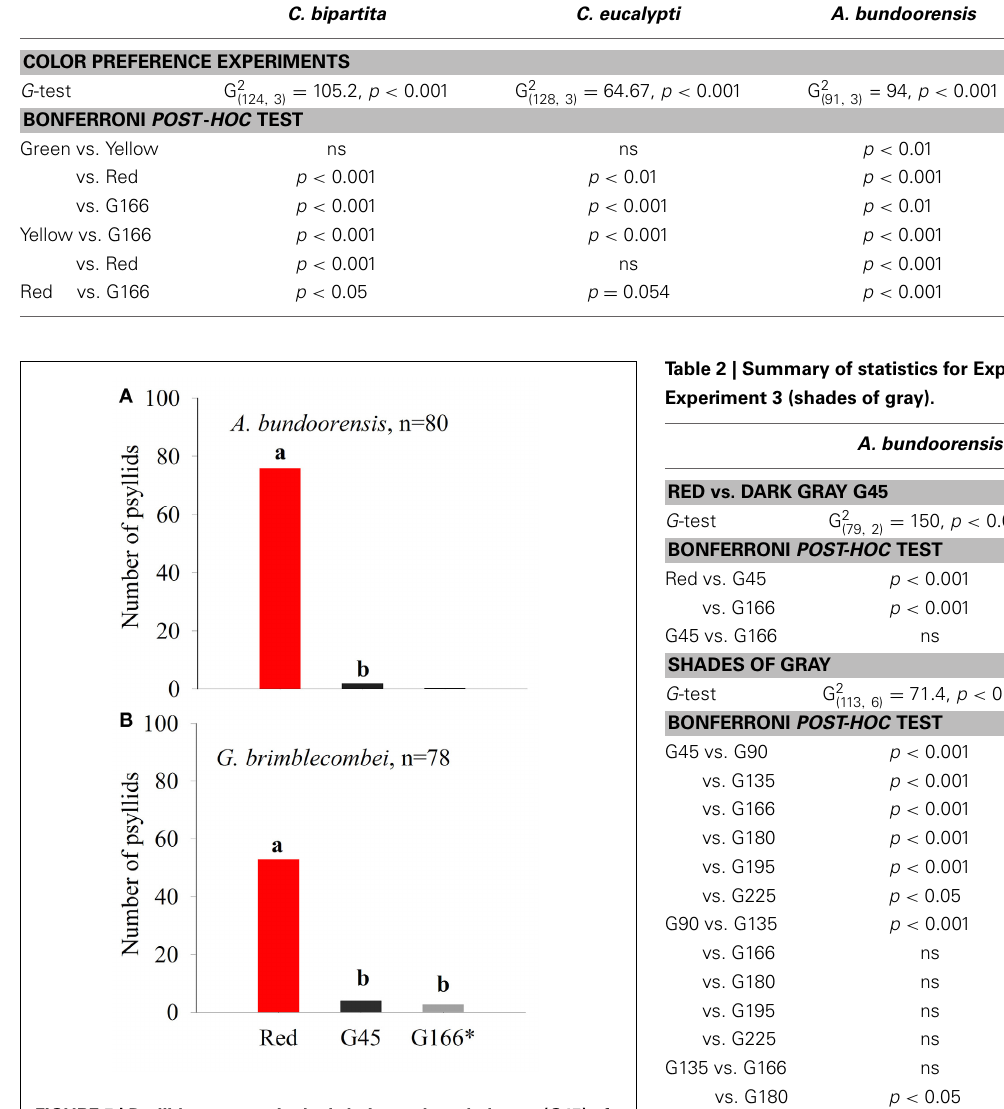
FIGURE 5 | Psyllid responses in dual choice, red vs. dark gray (G45) of (A) A. bundoorensis and (B) G. brimblecombei . ∗ Number of psyllids was normalized based upon the proportion of the circumference occupied by the background color in the arena.